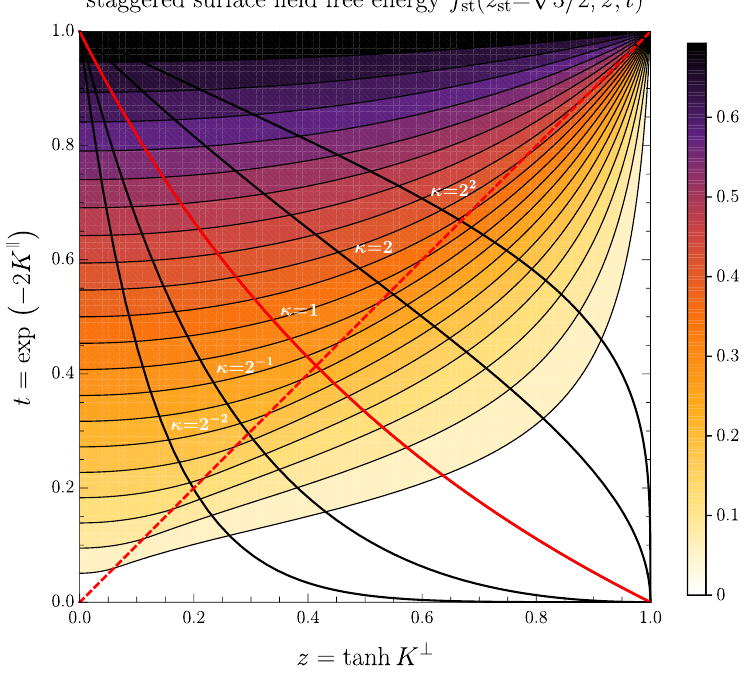
( z ; z , t ) , see (4.5). The st st = 1 the density diverges st